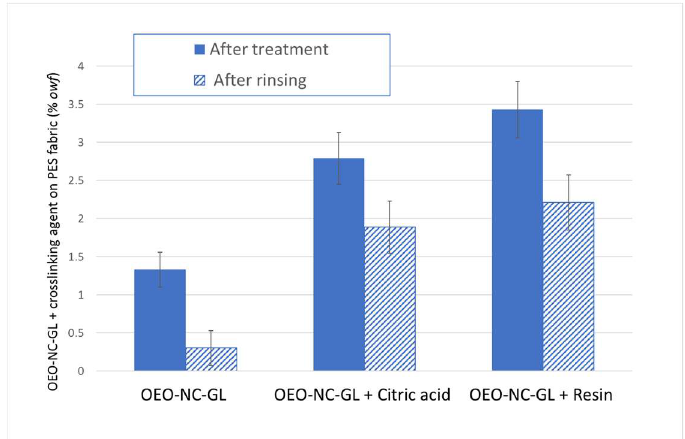
Figure 3. Adsorption and desorption results, % of product on PES fabric after OEO-NC-GL treatment and after rinsing. ( owf : over weight of fiber).